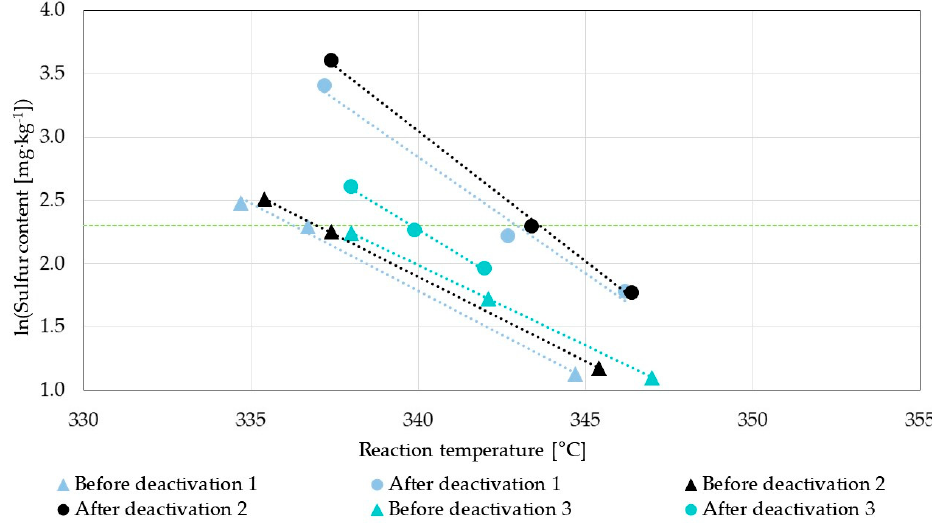
Figure 3. Influence of reaction temperature on sulfur content.